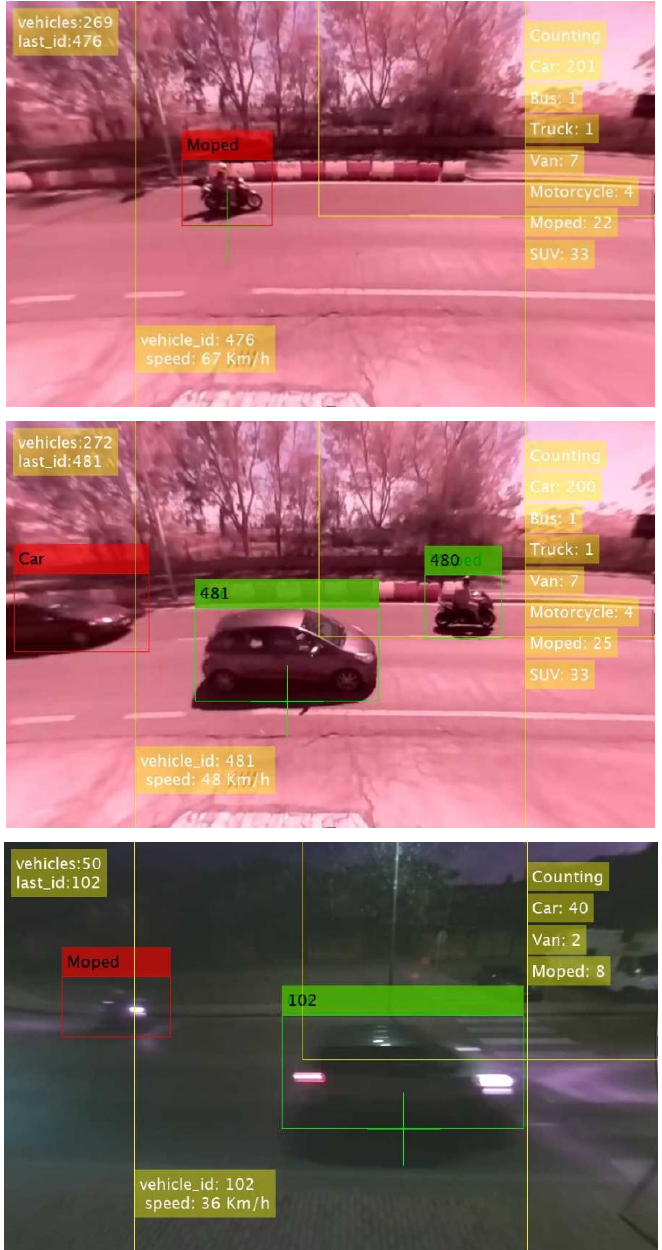
Figure 5. Examples of video processing via tracking-by-detection for daytime and nighttime.